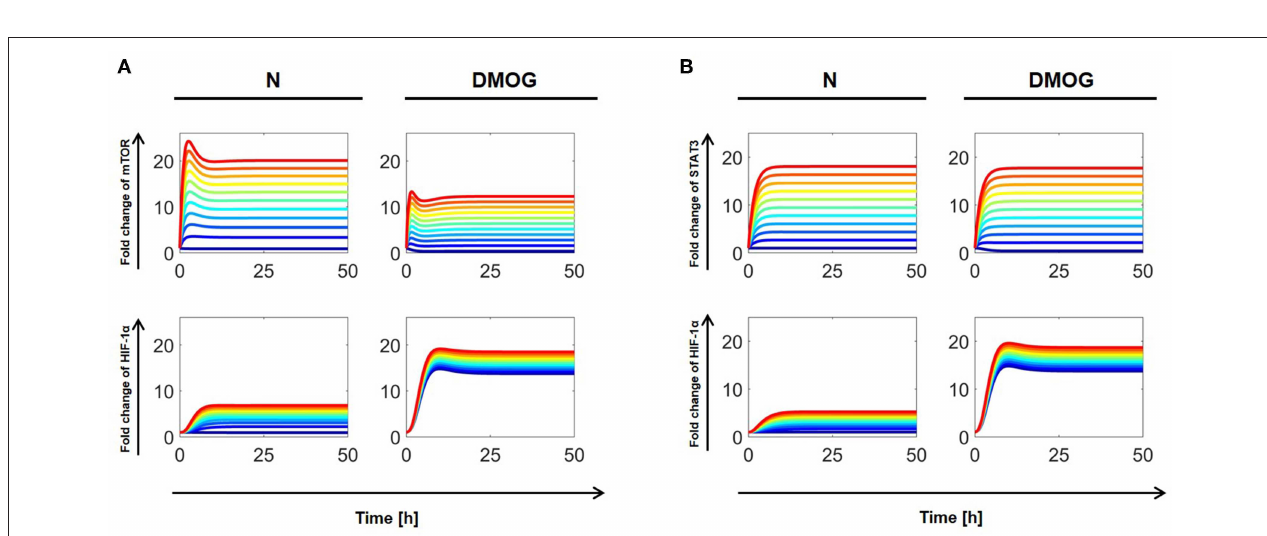
FIGURE 7 | (A) Effects of external mTOR regulation on total HIF-1 α in NK cells without (N) or with DMOG. External mTOR activation rate ( a 3 ) is varied in [0,10] nM h − 1 with regular steps. (B) Effects of external STAT3 regulation on total HIF-1 α . External STAT3 activation rate ( a 8 ) is varied in [0,10] nM h − 1 with regular steps. All other parameters and initial values are fixed as in Tables 1 , 2 . Curves with same color correspond to the same parameter value and follow the jet color map in MATLAB ® , with dark blue corresponding to the lowest value ( a j = 0 nM h − 1 , j = 3,8) and red to the highest value ( a j = 10 nM h − 1 , j =